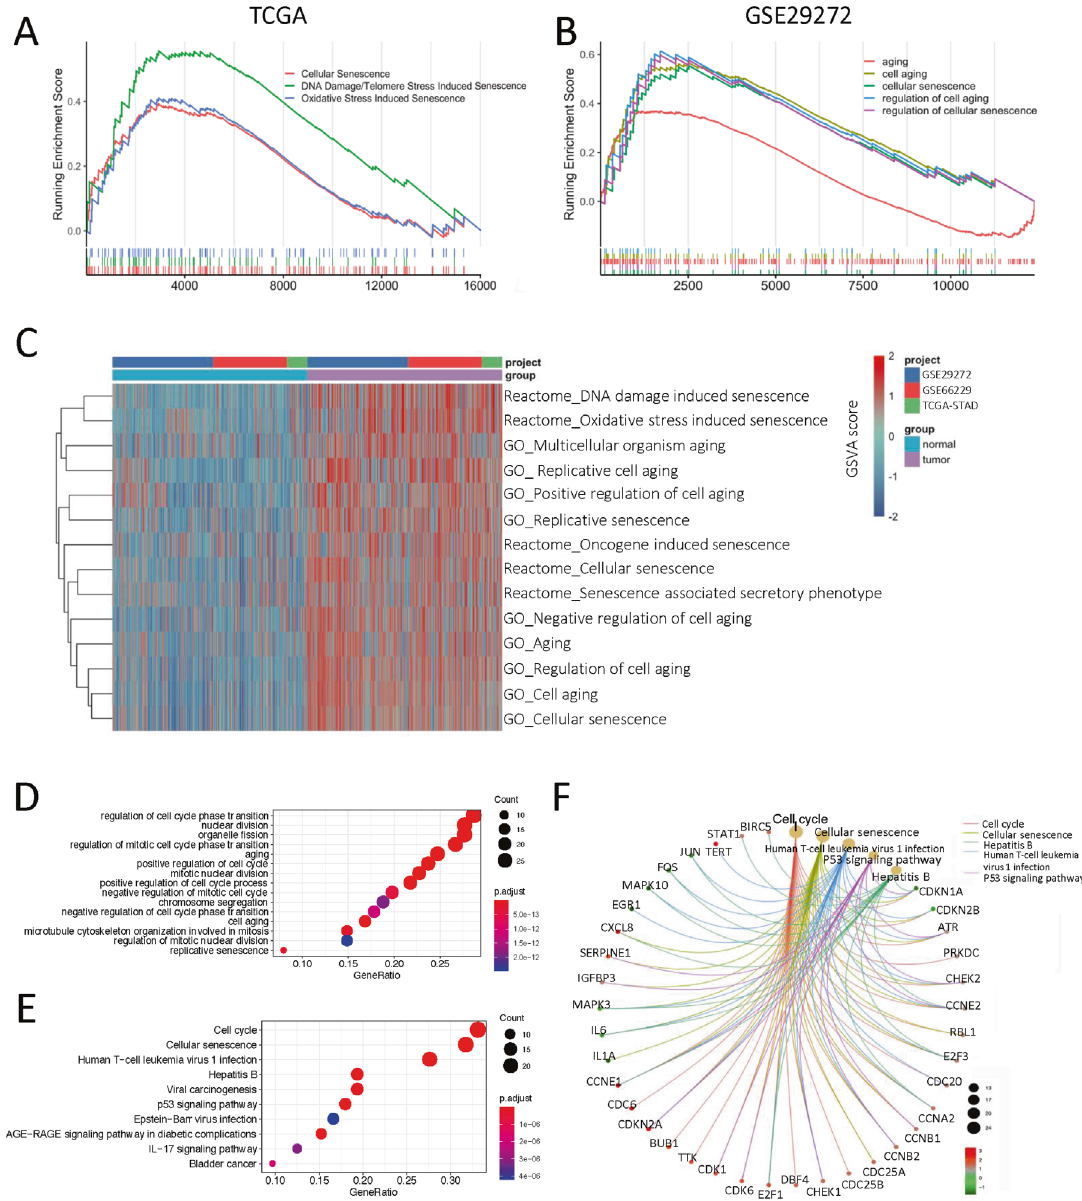
Fig. 2 Identi fi cation of the senescence character in gastric cancer. A GSEA plot showed that senescence-associated pathways were signi fi cantly enriched in GC relative to normal tissues in TCGA-STAD cohort. Multiple pathway enrichment results were indicated by corresponding colors. B GSEA plot exhibited the enriched GO terms associated with senescence based on GC versus normal gastric tissues in GSE29272 cohort. The different GO terms were displayed by corresponding colors. C GSVA enrichment analysis showing the quite different senescence features between GC and their paired adjacent normal tissues in multiple datasets. Heatmap displaying the GSVA score of senescence pathways and GO terms. Dot plots showing the signi fi cant enrichment results for senescence-associated genes in GO term ( D , top 15) and pathway ( E , top 10). The dot size and color represented the gene count and the weighted Fisher ’ s p value, respectively. F The interaction network exhibiting the top fi ve enriched pathways and their contained genes. The dot size of the pathways represented the gene count. The color of genes indicated the fold change of gene expression between GC and normal tissues in TCGA-STAD